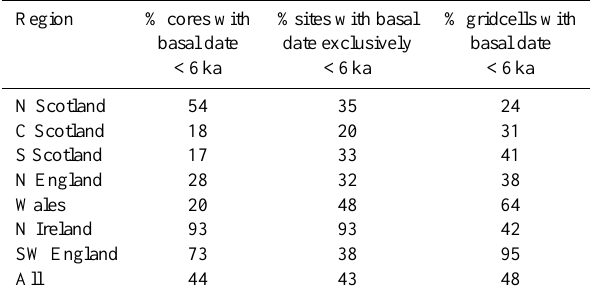
Table 2. Region by region break down of percentage of (a) cores with basal dates younger than 6ka (b) sites with basal dates exclu- sively younger than 6ka (c) % gridcells that PeatStash predicts to have initiated after 6ka when run with the pollen-based climate re-